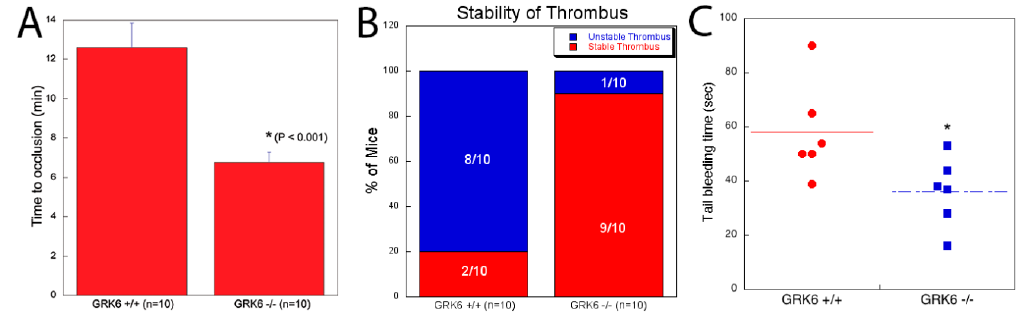
Figure 6. Enhanced in vivo platelet functional responses, thrombus growth, and stability in GRK6 − / − mice in the FeCl 3 injury model. The carotid arteries of WT and GRK6 − / − mice were injured by 5% FeCl 3 for 90 s. Flow rates through the carotid artery were measured for 30 min with a Doppler flow probe following vascular injury. ( A ) Time to occlusion of the carotid artery in GRK6 +/+ and GRK6 − / − mice was measured. Data are presented as mean ± SE. Statistical analysis was performed using a Student t test (* p < 0.001). ( B ) Thrombus stability was assessed by determining the percentage of mice that maintain stable thrombi for at least 10 min. ( C ) Tail bleeding time was measured in GRK6 +/+ and GRK6 − / − mice following excision of the distal 4 mm of the tail. Data are mean ± SE. *, p < 0.05.